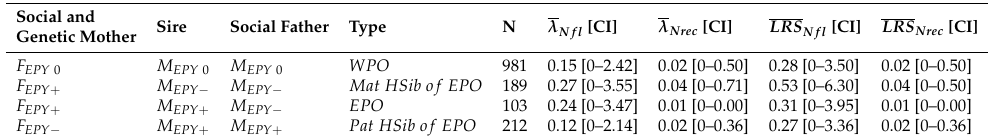
Table 2. The total fitness of the fledglings related to the differences in genetic and social parents in the Western Siberian population of the European pied